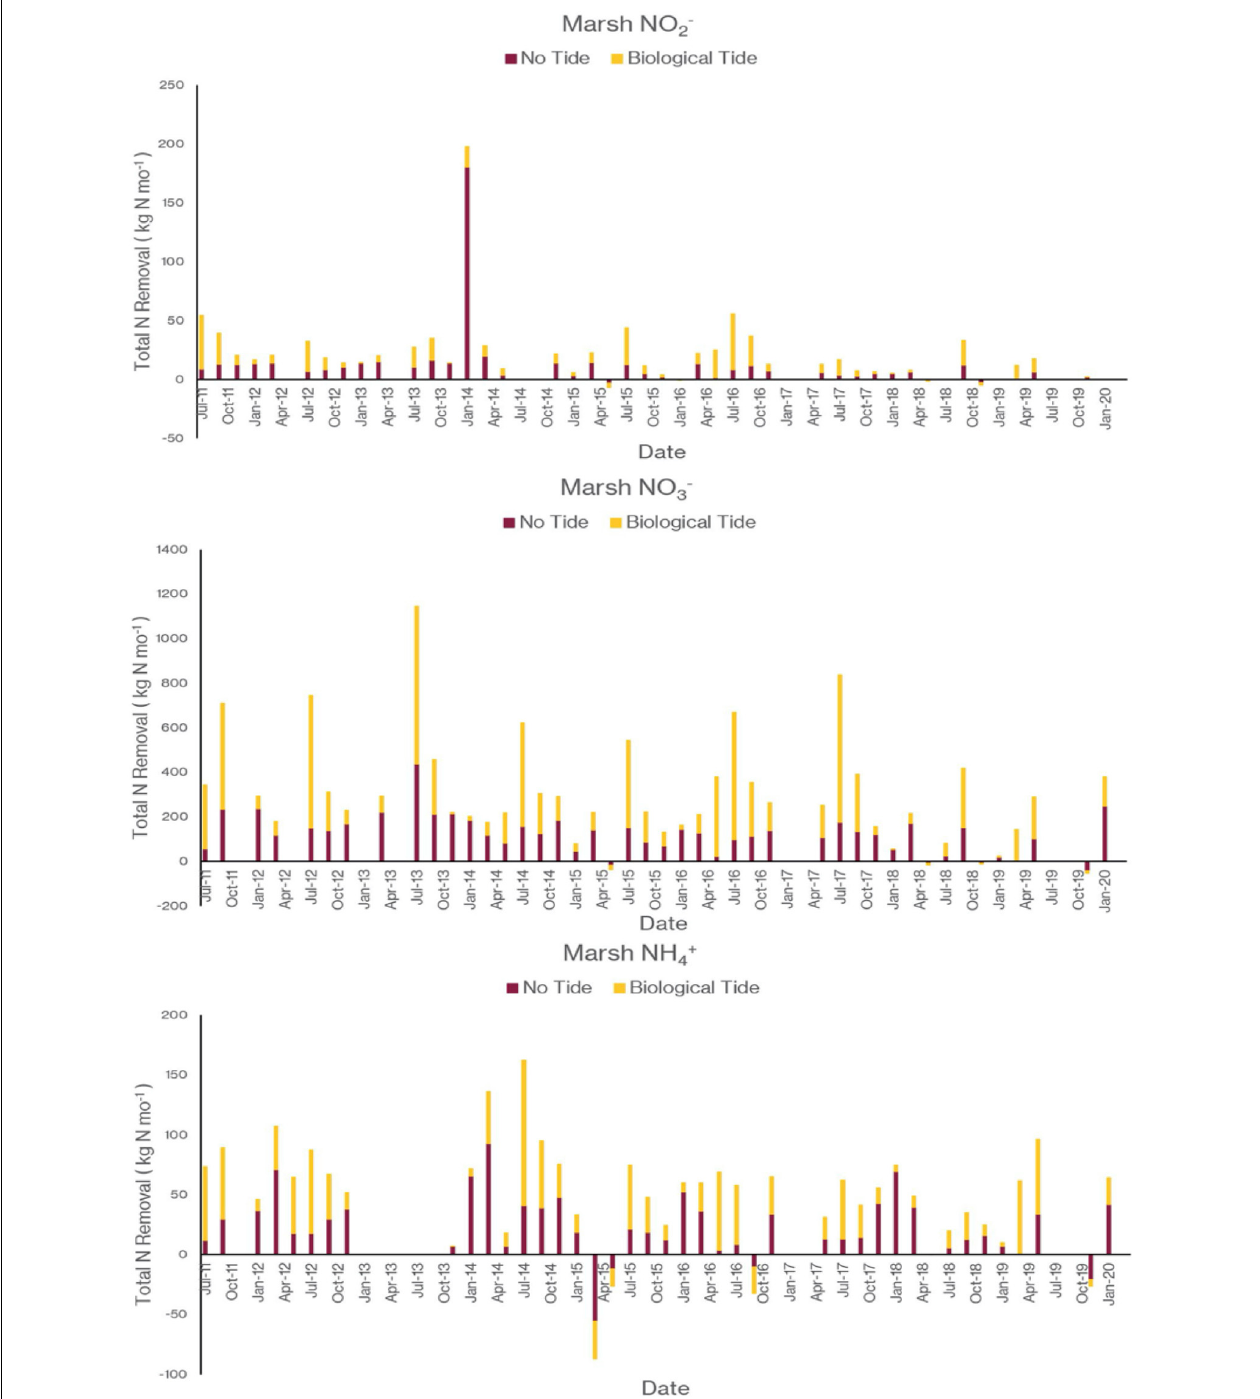
FIGURE 5 | The contribution of the Biological Tide to inorganic nitrogen sequestration by the 21 ha vegetated marsh for (top) NO 2 - , (middle) NO 3 - , and (bottom) NH 4 + (modified from Treese et al.,